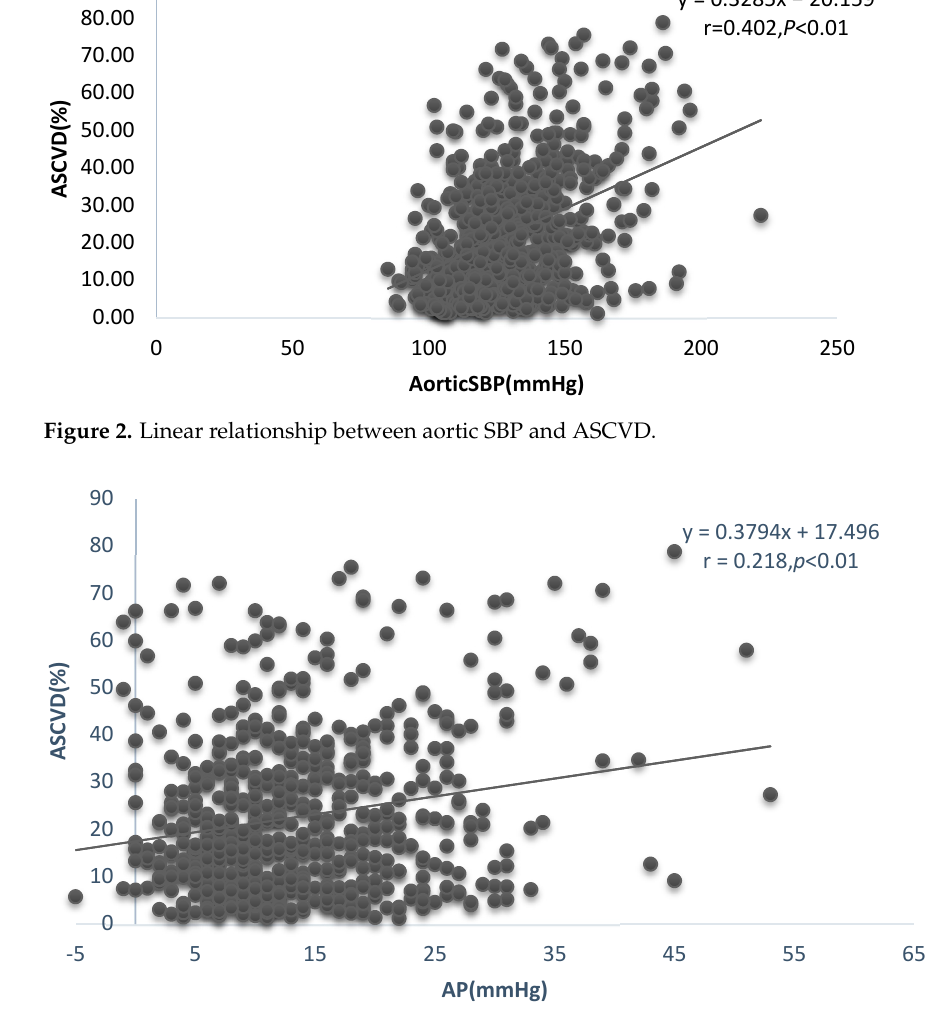
Figure 3. Linear relationship between AP and ASCVD.